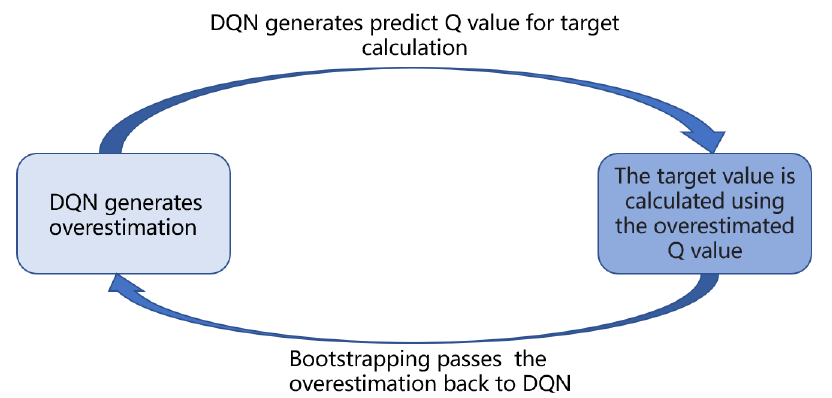
Figure 1. Overestimation of the process of transmission and facilitation between DQN and